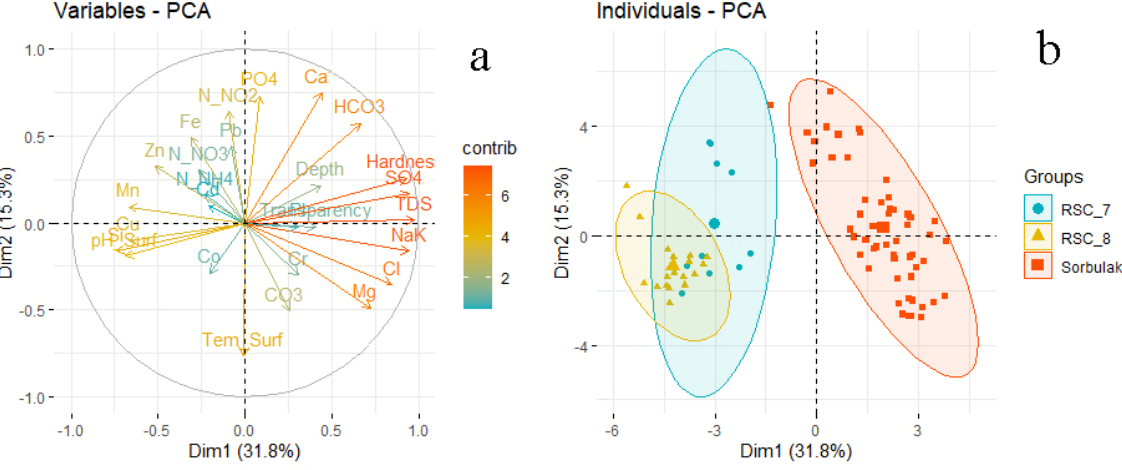
Figure 5. Principal component analysis (PCA) biplot of relationships between environmental variables ( a ); distribution of variables by clusters ( b ) in wastewater reservoirs of the Right Bank Sorbulak Canal system, 2021.